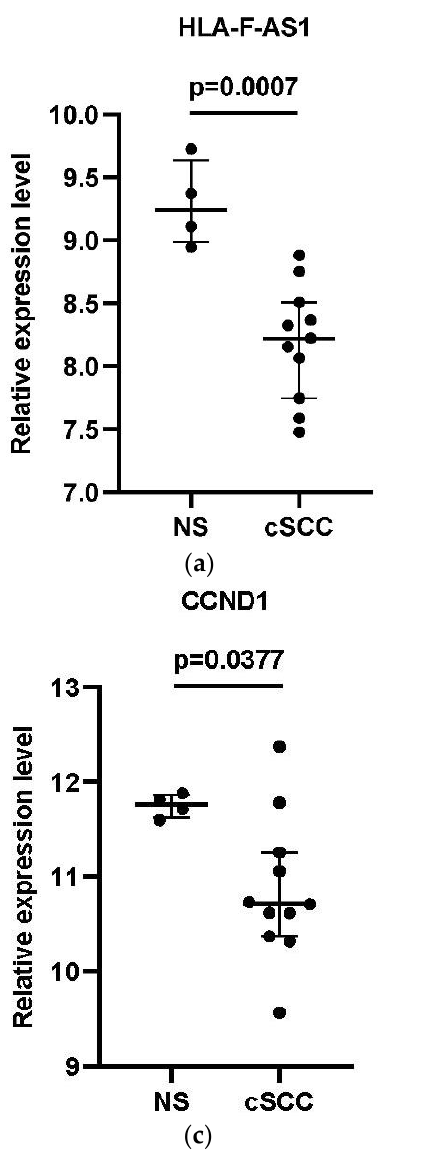
Figure 6. External validation of the four core genes in the GSE7553 datasets. ( a ) The relative expression level of HLA-F-AS1 between cSCC and NS samples; ( b ) the relative expression level of AGO4 between cSCC and NS samples; ( c ) the relative expression level of CCND1 between cSCC and NS samples; ( d ) the relative expression level of E2F1 between cSCC and NS samples. The log 2 transformed expression level corresponded with the relative expression level. Data are presented as a median with interquartile ranges. An unpaired t-test was used for the comparison of the relative expression level between the two groups.